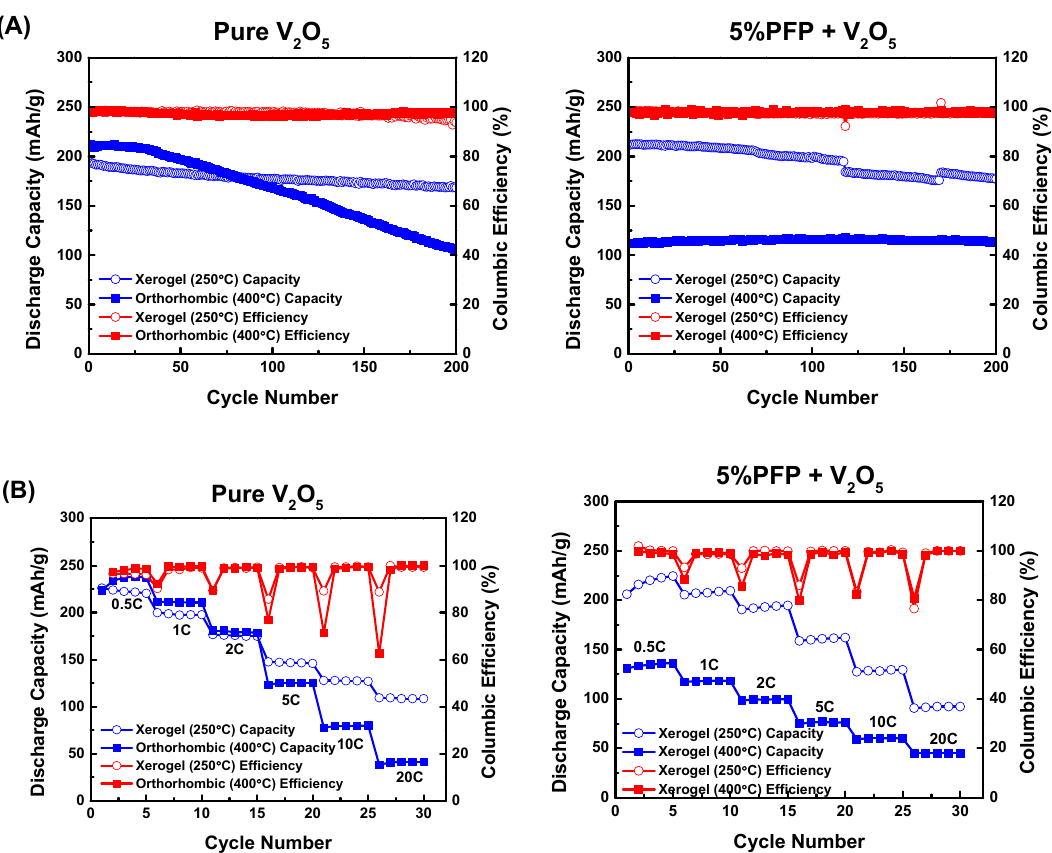
Figure 4. ( A ) Respective cycling performance of pure V 2 O 5 and V 2 O 5 + 5% PFP at 250 ◦ C and 400 ◦ C; ( B ) respective rate performance of pure V 2 O 5 and V 2 O 5 + 5% PFP at 250 ◦ C and 400 ◦ C. The small capacity drop for the 5% PFP sample between about 130 to 160 cycles is an artifact due to an unfortunate power interruption during testing.